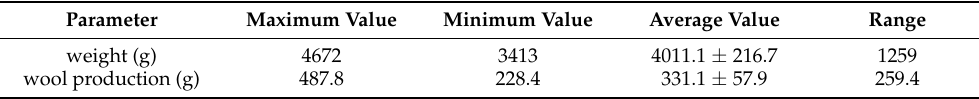
Table 1. Population weight and wool production data of adult Angora